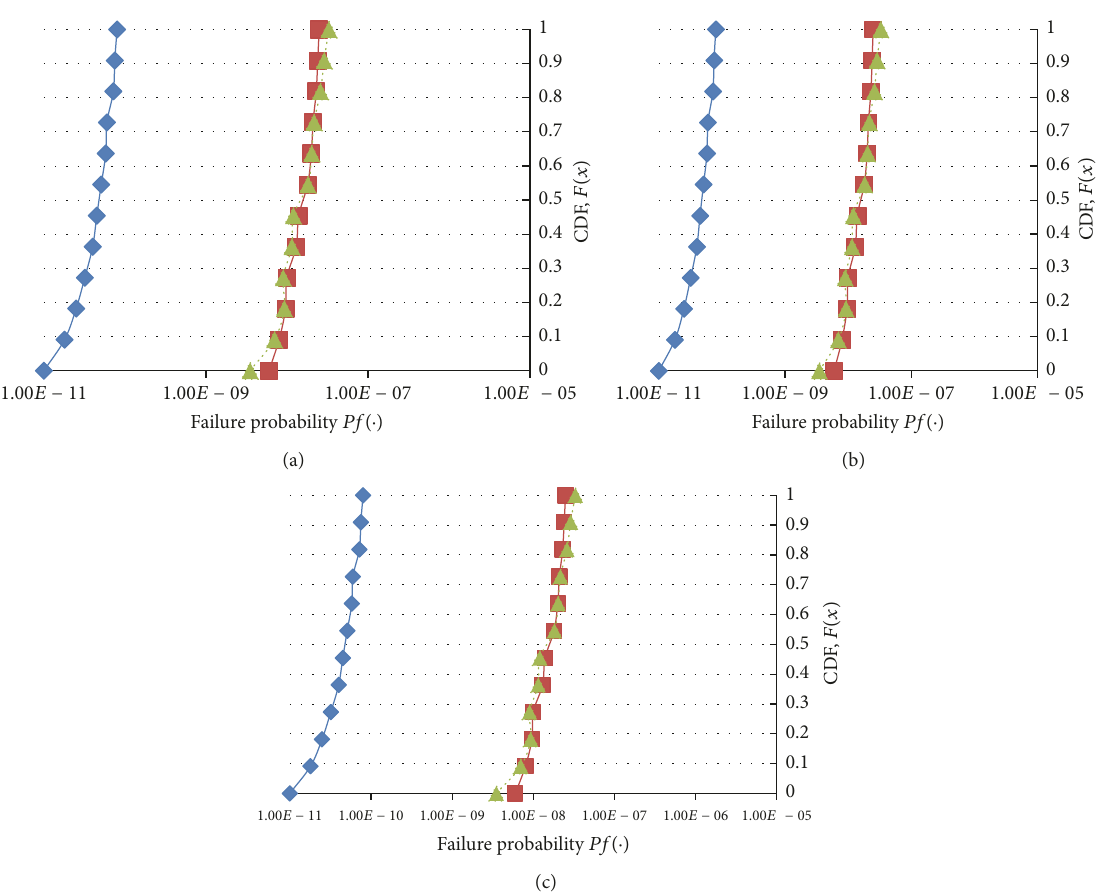
∗ The K-S test is conducted between the Monte Carlo simulated results (sample size = 100000) and the interval analysis results. The hypothesis is that they are from different continuous distributions. Significance level is at 5 % .